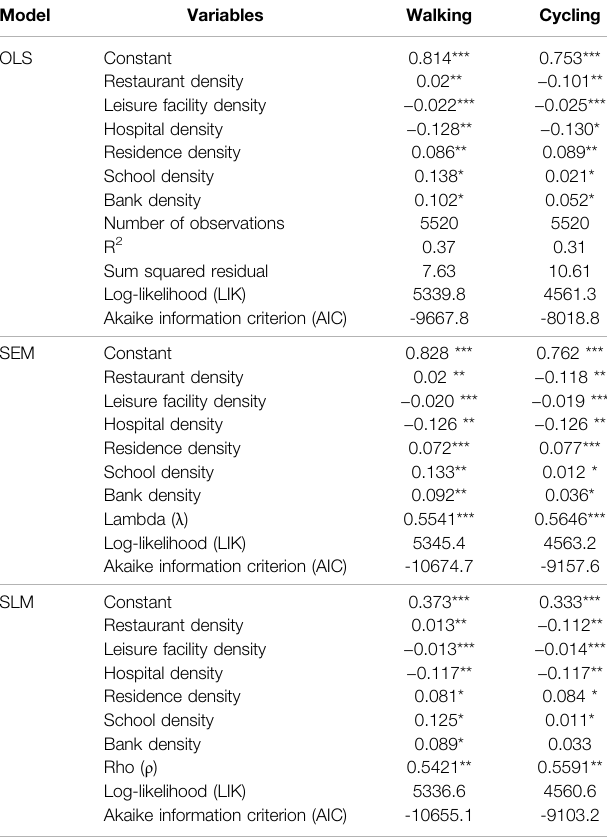
TABLE 6 | Model performance and regression result of ATTS and POI density Model